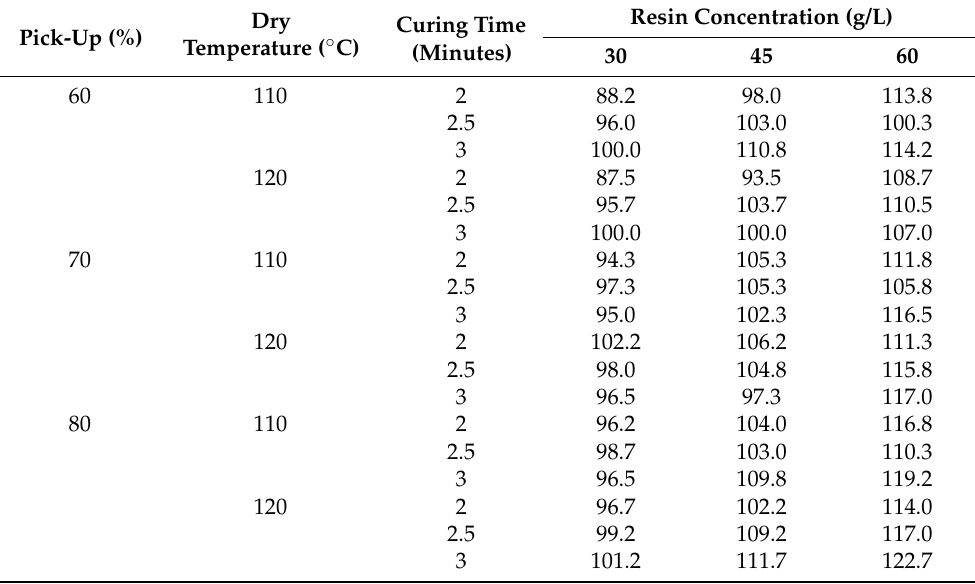
Table 2. Fabric recovery